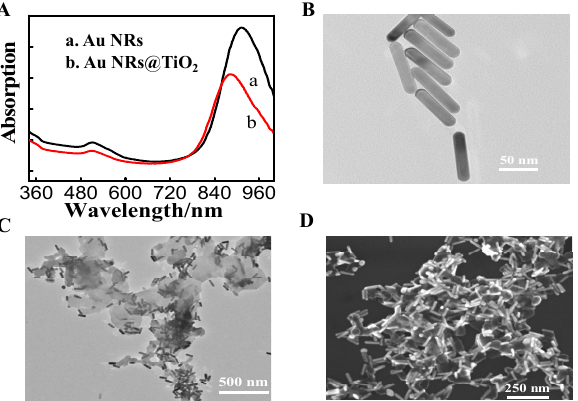
Figure 1. ( A ) UV − Vis spectra of Au NRs and Au NRs@TiO 2 nanostructures; ( B , C ) were TEM images of Au NRs and Au NRs@TiO 2 , respectively. ( D ) Scanning electronic microscopy (SEM) image of Au NRs@TiO 2.